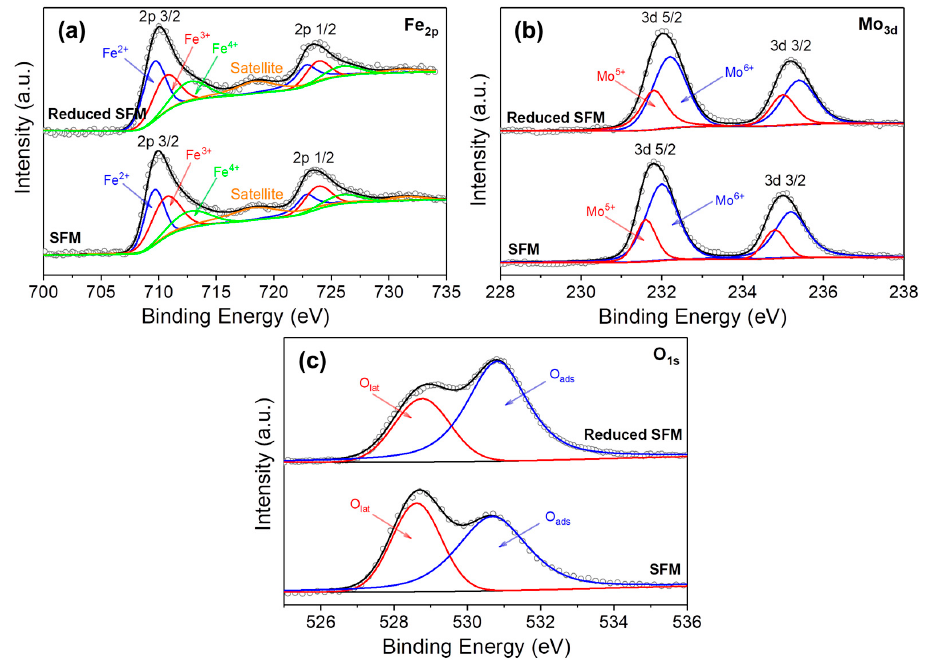
Figure 6. Experimental and deconvoluted Fe 2p ( a ), Mo 3d ( b ) and O 1s ( c ) XPS spectra for SFMO before and after reduction in pure H 2 at 800 °C for 2 h.